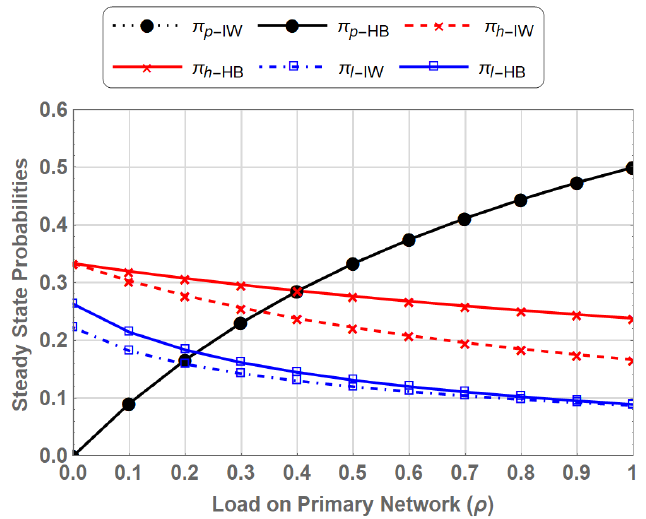
Figure 11. Comparison of Stationary probabilities for PN-MC-IW and PN-MC-HB.